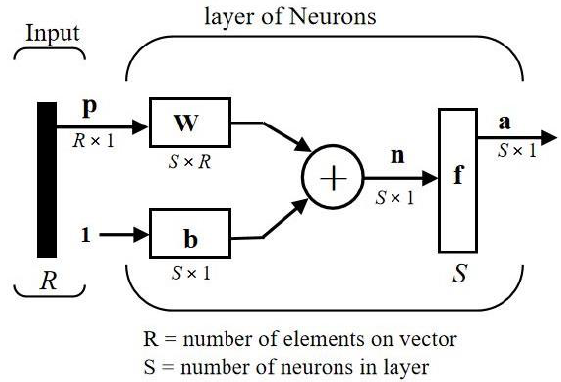
Figure 2. Single-layer neural network architecture.